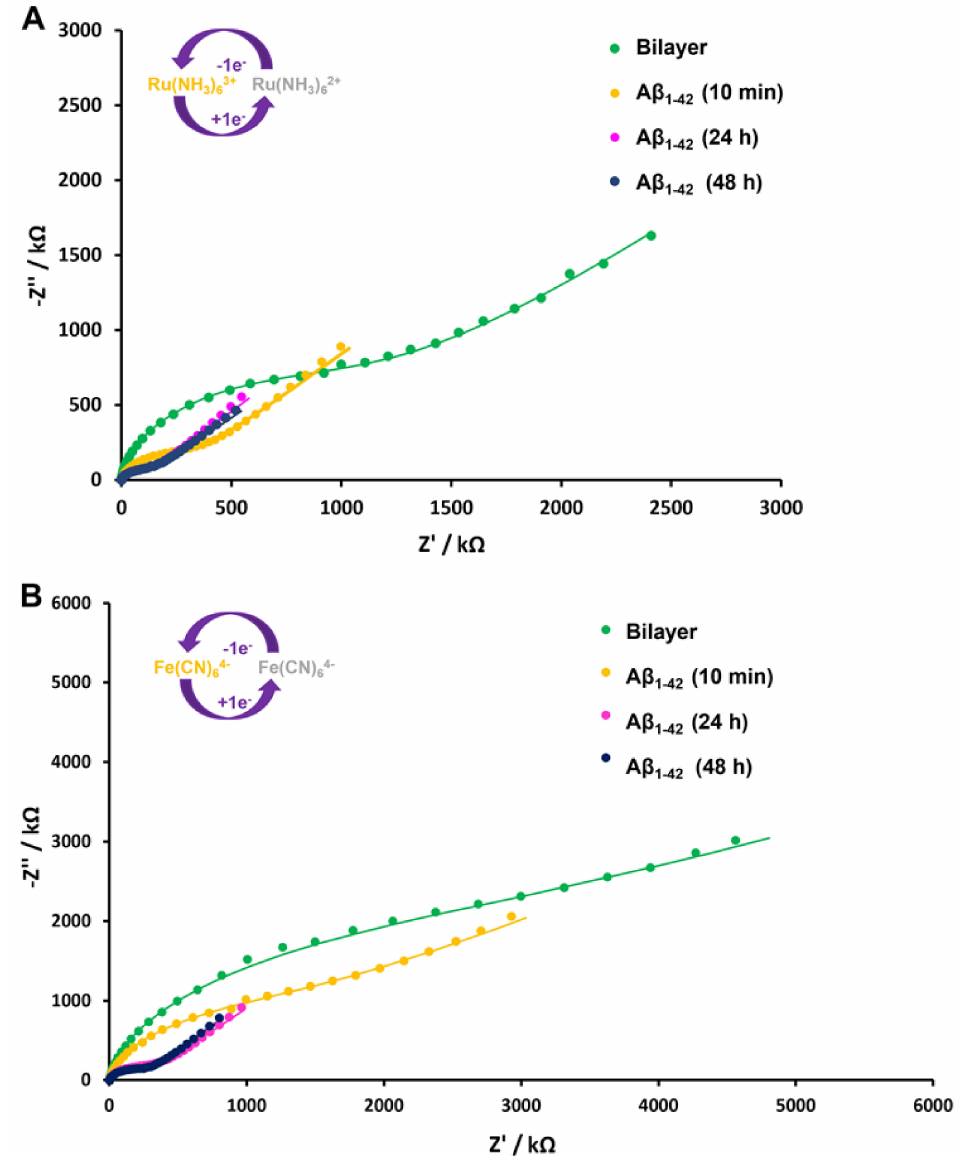
Figure 6. Nyquist plots of GCE-DDAN-DHP bilayer using [Ru(NH 3 ) 6 ] 3+ ( A ) and [Fe(CN) 6 ] 3 − /4 − ( B ) as the redox probe in the absence of A β 1–42 (green), and after 10 min (yellow), 24 h (purple) and 48 h (dark blue) incubation in a solution of A β 1–42 . All dots represent the experimental data and solid lines represent the simulated data with the applied frequency from 100 MHz to 100 kHz. The values of each equivalent circuit element are included in Table